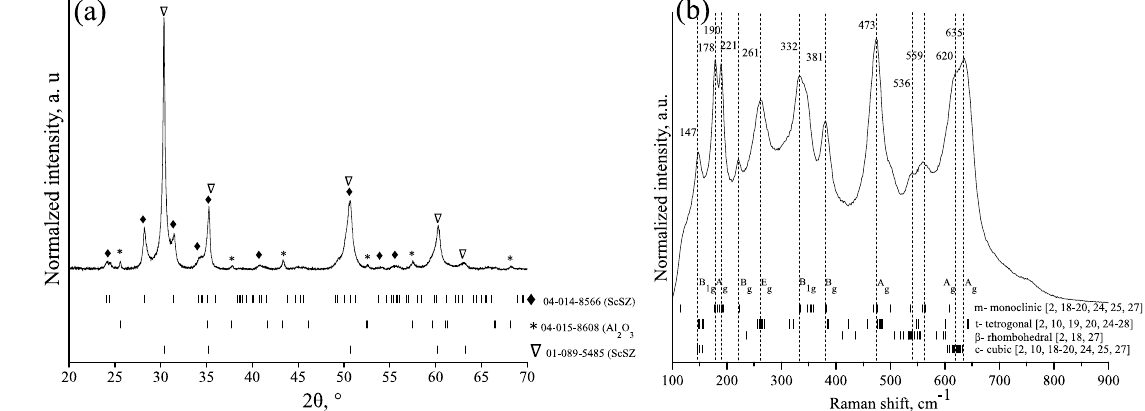
Figure 1. 6ScAlSZ powders: ( a ) X-ray diffraction (XRD) patterns and ( b ) Raman shifts. Table 1. EDS analysis results of ScAlSZ thin films, ( v d —deposition rate, T d —substrate temperature during deposition, and c —atomic